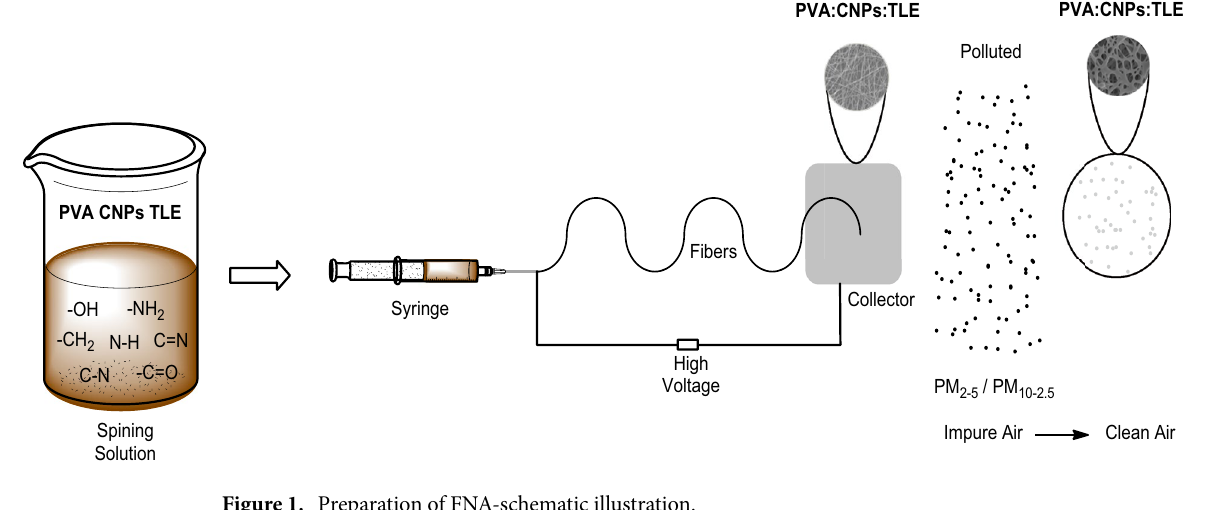
Figure 1. Preparation of FNA-schematic